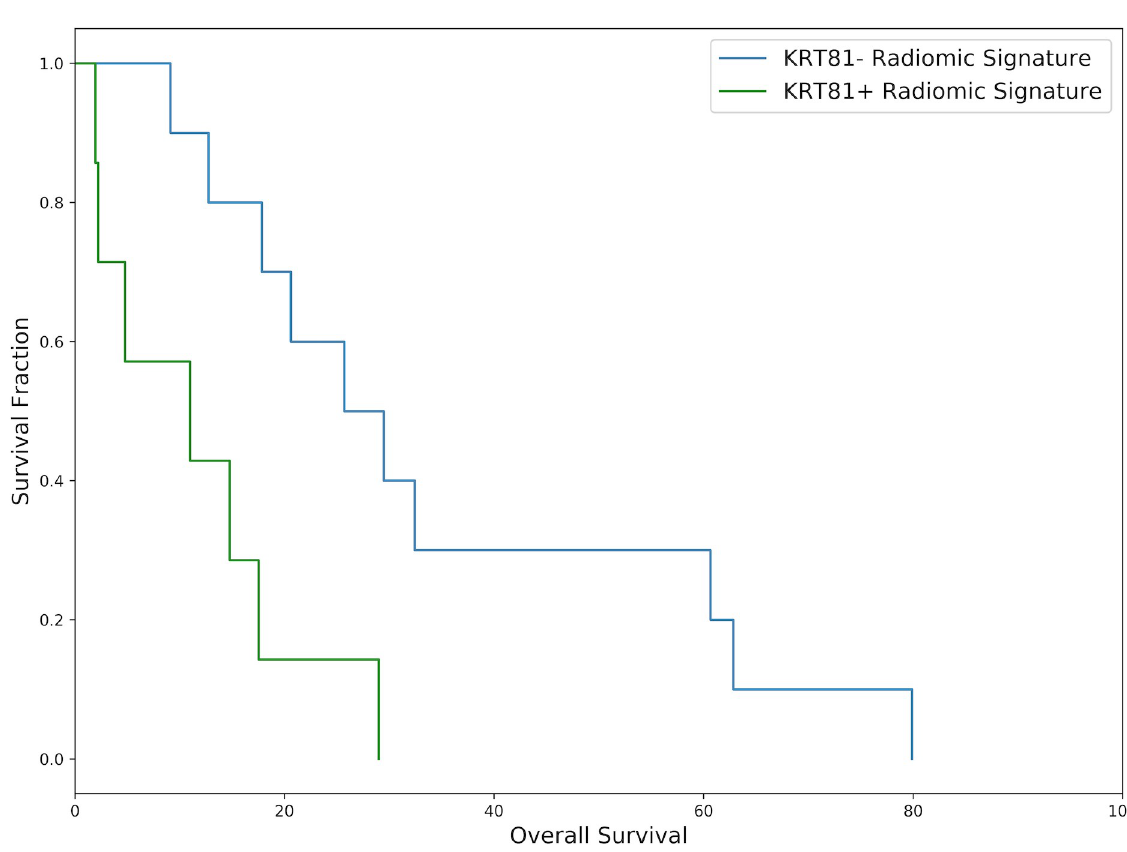
Fig 5. Exemplary Kaplan-Meier overall survival curve drawn from the 10 cross-validation folds representing the median hazard ratio. Patients with a high risk radiomic phenotype experienced significantly diminished survival (10.97 vs. 25.70 months median OS, log-rank-test p = 0.006, HR = 3.03, N =